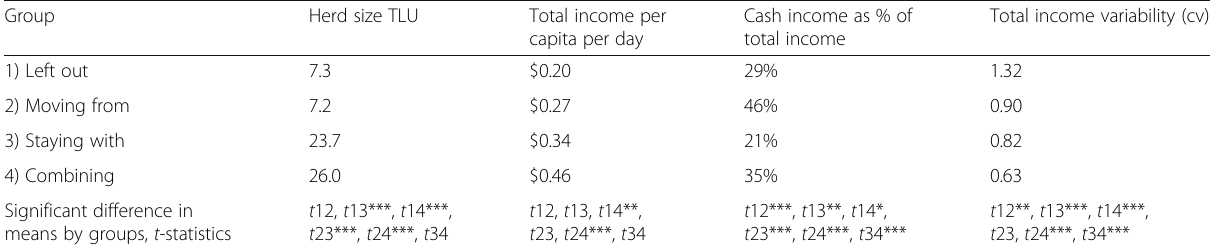
Table 2 Average herd size and income measures by